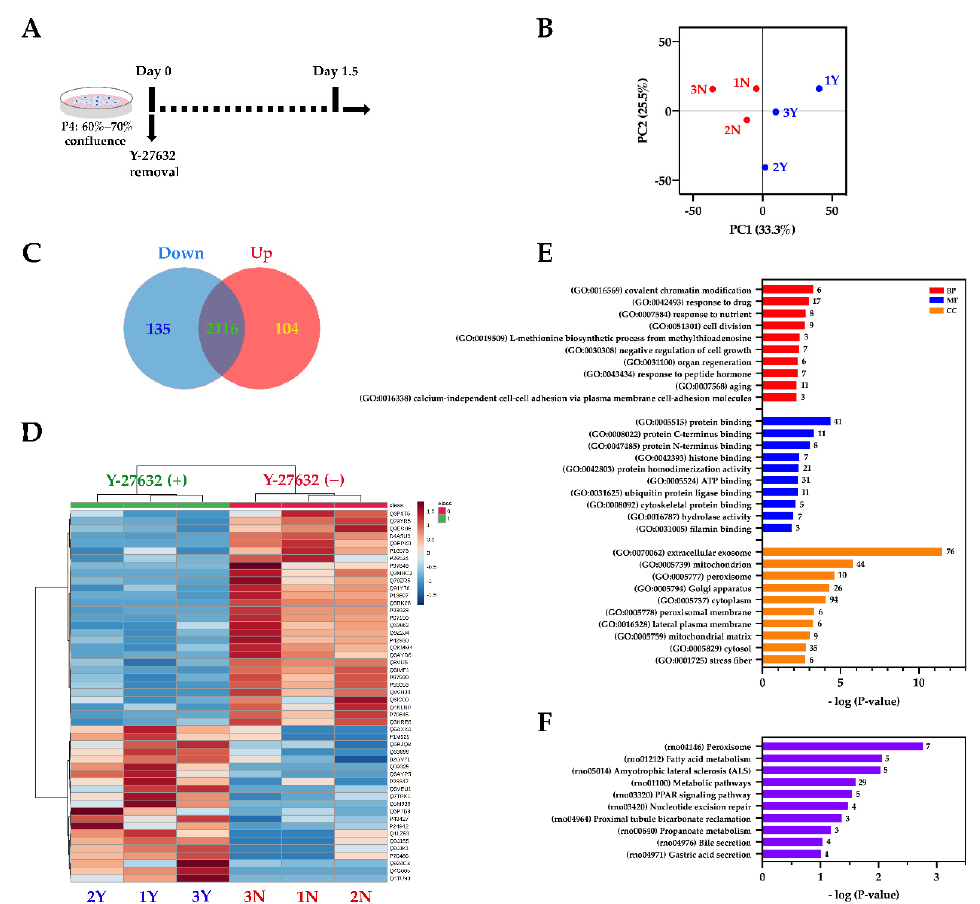
Figure 3. Comparative proteomic analysis of RLKs in the presence and absence of Y-27632. ( A ) Ex- perimental scheme. Cells were continuously cultured in MTCM with Y-27632 till passage 4. Then, Y-27632 was removed from the culture medium when cell culture reached 60–70% confluence on day 0. Cells on day 0 and day 1.5 were harvested for analysis. ( B ) Score plot of principal component analysis (PCA). RLKs treated with (blue dots, 1Y–3Y) or without (red dots, 1N–3N) Y-27632 were separated into two groups ( n = 3 biological replicates). ( C ) Venn diagram showing the numbers of upregulated (Up) and downregulated (Down) proteins following the removal of Y-27632. ( D ) Hierar- chical clustering showing the top 50 differentially expressed proteins. Ward clustering algorithm, Euclidean distance measure, and autoscale features were used. ( E ) Gene Ontology (GO) enrichment analysis of the 239 differentially expressed proteins. The 10 most significantly enriched GO terms in biological process (BP), molecular function (MF), and cell component (CC) are presented. The number on the right side of each column represents the number of proteins associated with the corresponding GO term. ( F ) KEGG pathway enrichment analysis of the 239 differentially expressed proteins. The 10 most significantly enriched pathways are presented. The number on the right side of each column represents the number of proteins associated with the corresponding KEGG